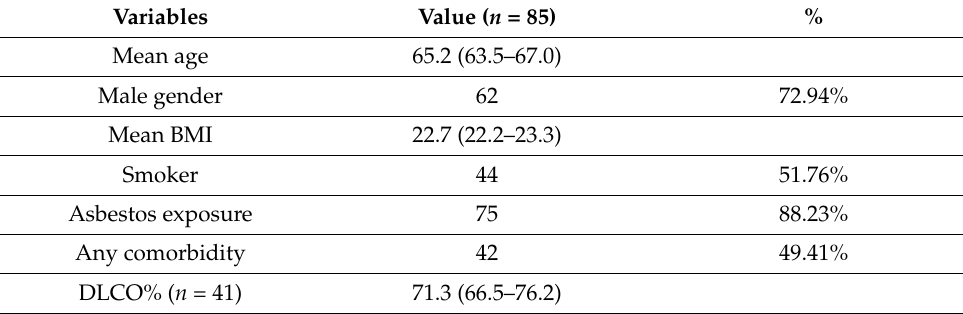
Table 1. Patients’ clinical and pathological